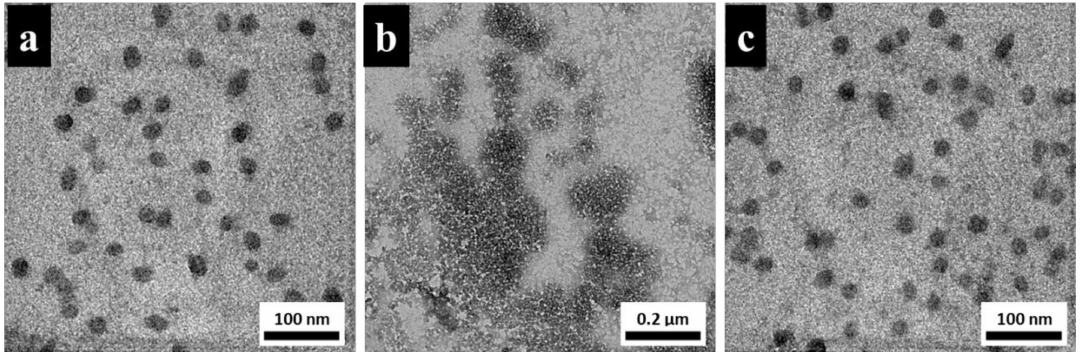
Figure 5. Transmission electron micrographs of samples prepared from an aqueous solution of polymer 5 before alkylation ( a ), after alkylation ( b ), and after dealkylation ( c